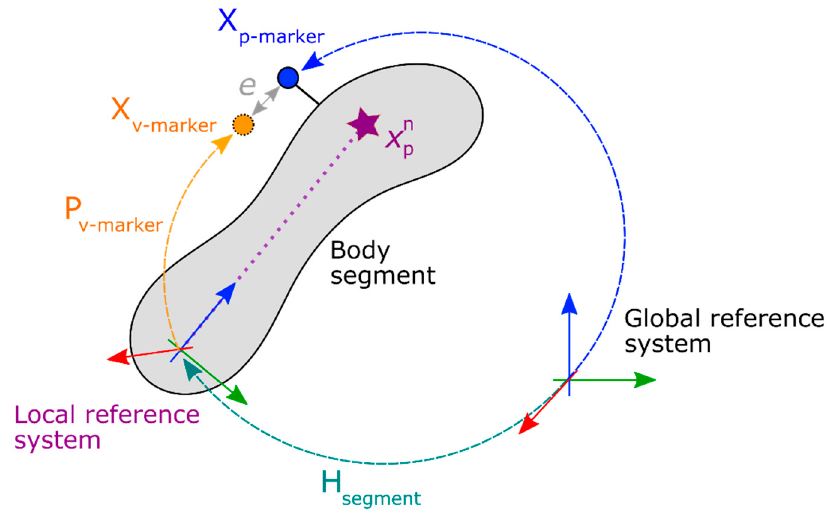
Figure 9. Definition of the virtual markers’ position based on the real marker relative position and the local reference system of the body measured using the multi-Kinect system.